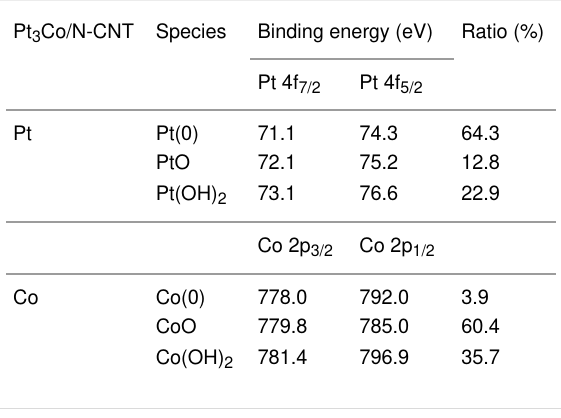
Table 5: Binding energies and ratio of Pt and Co species obtained from XPS spectra. Pt 3 Co/N-CNT Species